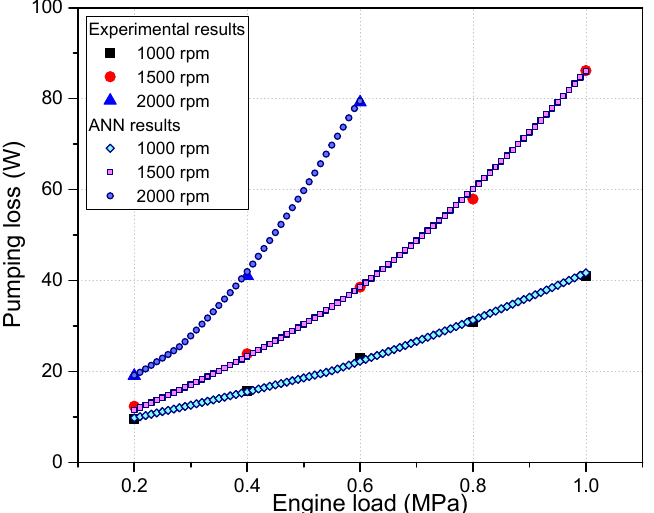
Figure 7. Pumping losses of the TEG obtained by integrating the volumetric flow rate and pressure drop across the TEG.